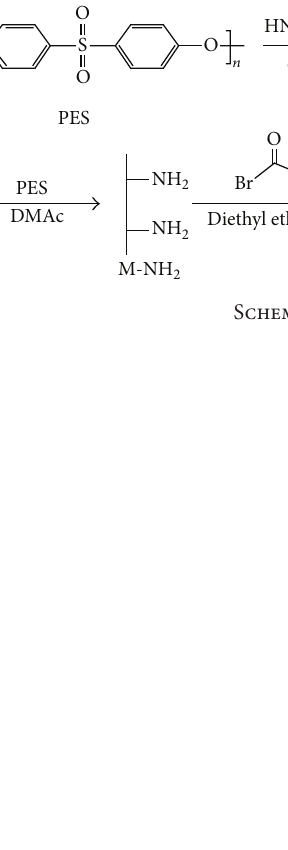
Figure 1: ATR-FTIR spectra for the M-PES and